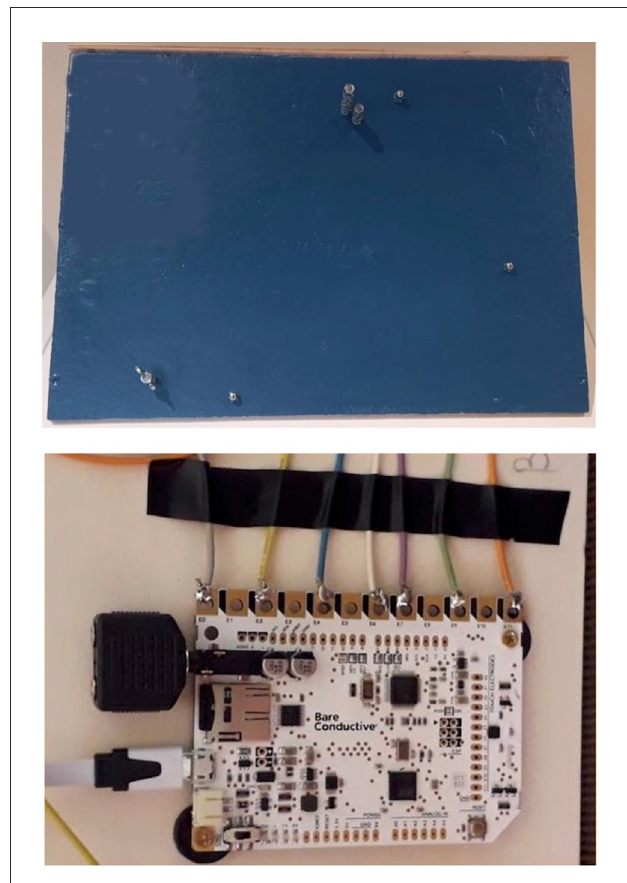
FIGURE3 The multi-sensory exhibit “Sense the Universe.” (Top) Front of the tablet, showing the bolts used to represent sources. (Bottom) Electronic board used to reproduce